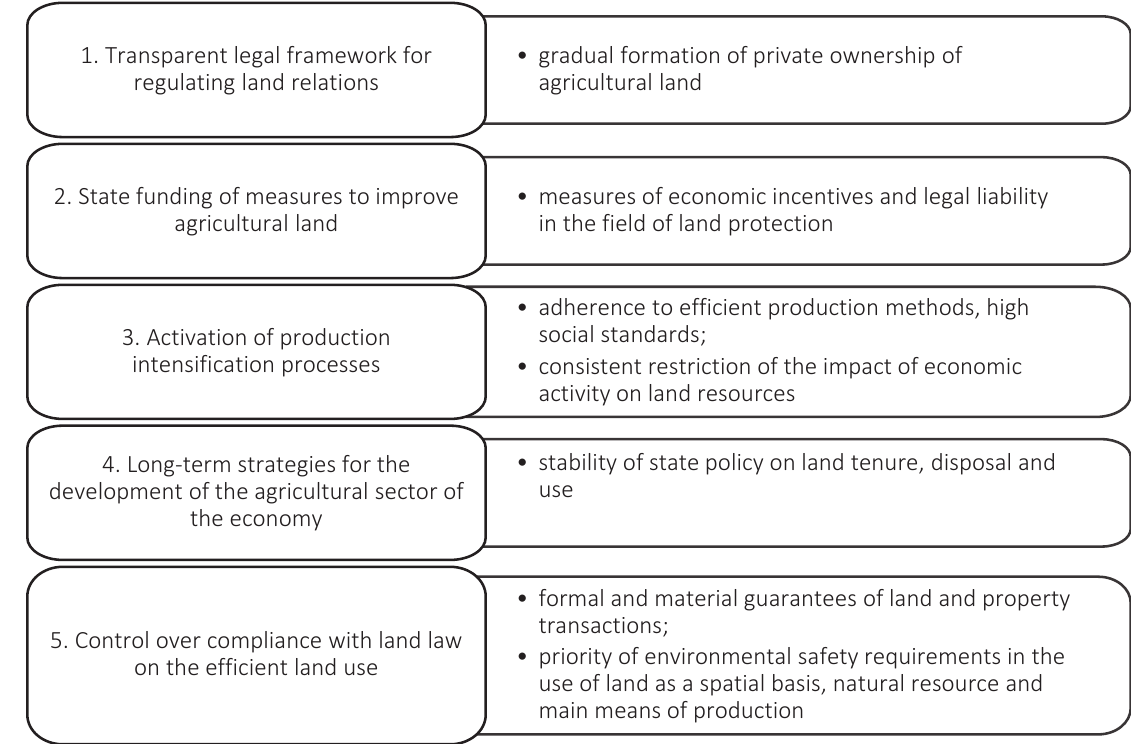
Figure 1. Factors of effective transformation of land relations in Central European